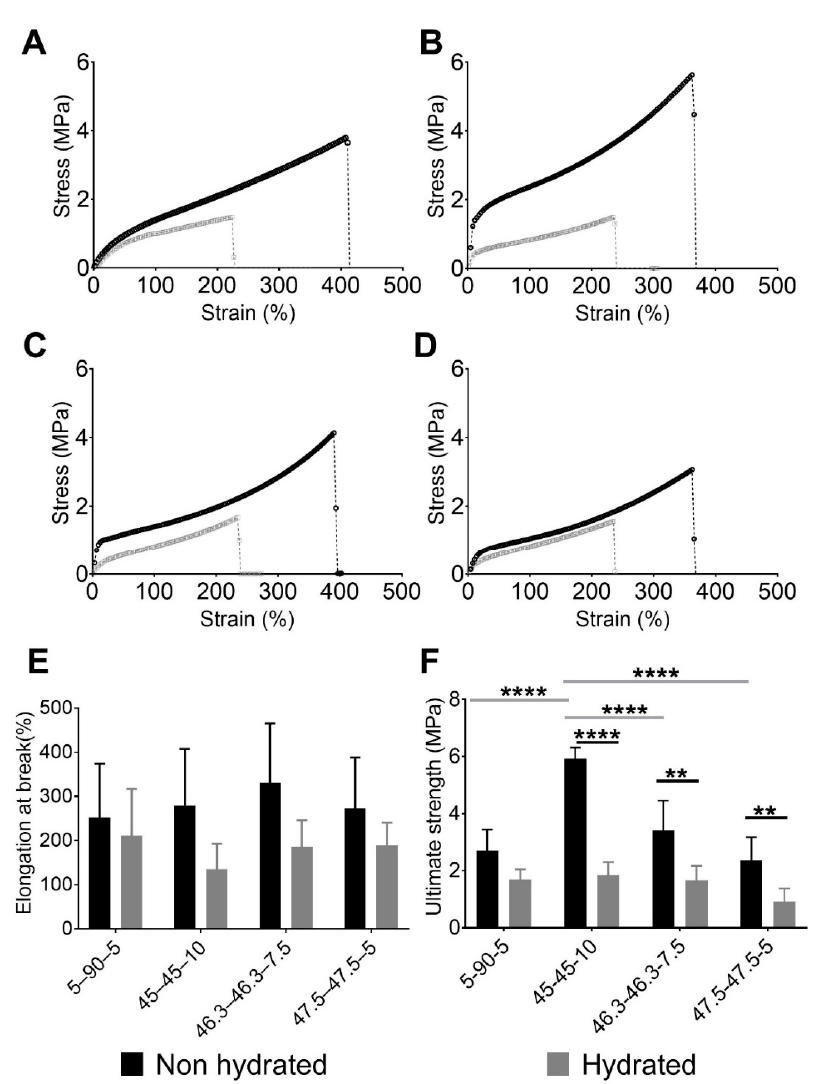
Figure 2. Engineering stress and strain performances of evaluated PUs showing the effect of the composition and softening of PUs after hydration. Stress vs. strain of non-hydrated and hydrated PUs: ( A ) 5–90–5, ( B ) 45–45–10, ( C ) 46.3–46.3–7.5, and ( D ) 47.5–47.5–5. ( E ) Elongation at break values of non-hydrated and hydrated PUs and ( F ) ultimate strengths of non-hydrated and hydrated PUs. In E and F, data are presented as the mean ± standard deviation (n = 5). Gray horizontal bars indicate significant differences between the material compositions, while black horizontal bars show the differences between hydration states. ** 0.001 ≤ p < 0.01, and **** p ≤ 0.0001. Figure 2E,F show the elongation at break and ultimate strength respectively, of each PU studied. The ultimate strength and elongation at break were evaluated using normality tests and both variables passed (alpha = 0.05). Regarding elongation at break, no significant differences were observed between the PU compositions and hydration states. In terms of the ultimate strength, an effect of the composition was observed in the non-hydrated state. The largest concentration of PE produced PUs with the greatest values, with 45–45–10 reaching an average value of 5.92 MPa. By contrast, the PUs with the lowest concentrations of PE, namely 5–90–5 and 47.5–47.5–5, had stresses of 2.69 and 2.36 MPa, respectively. Statistical analyses supported these findings, with significant differences in ultimate strength found between 45–45–10 and the other PUs. Moreover, the